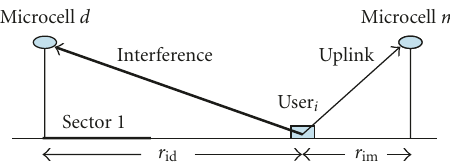
Figure 3: Schematic diagram of base stations and mobiles for high- way